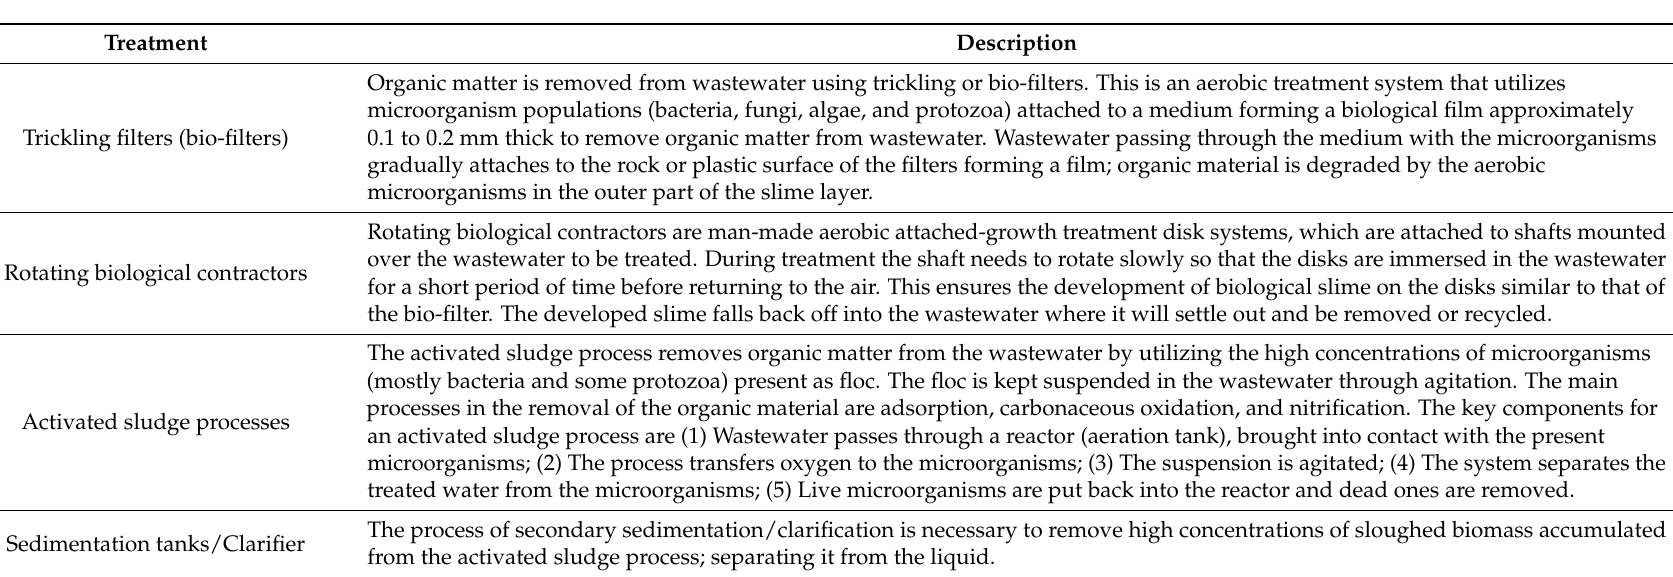
Table 2. Overview of commonly used secondary wastewater treatment processes in South